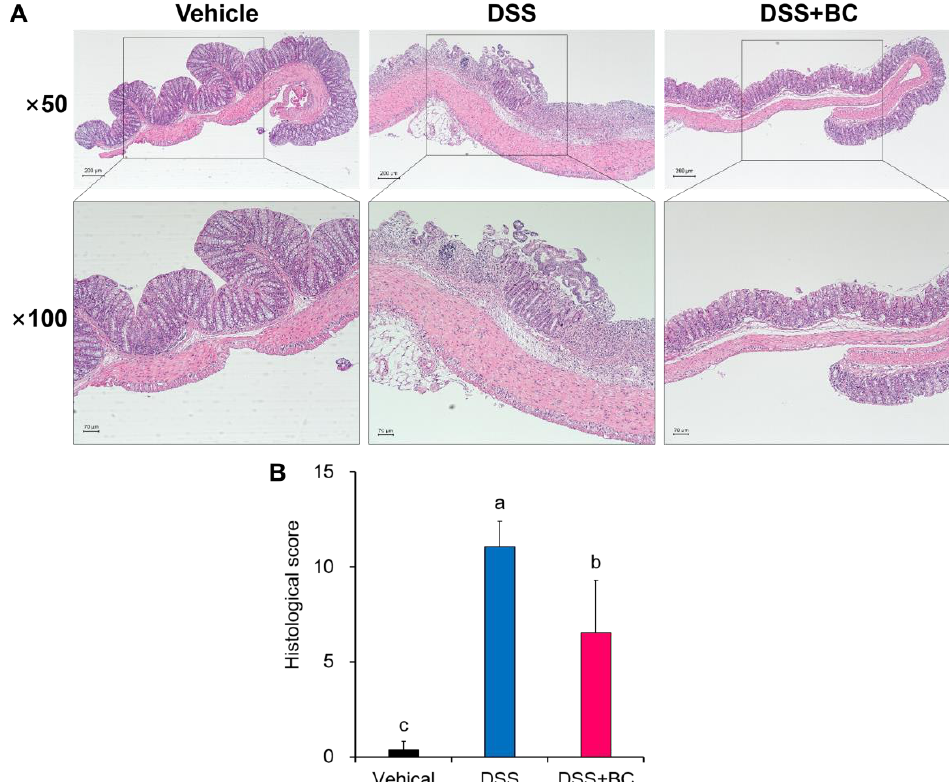
Figure 2. Effects of blackcurrant on the colon damage of DSS-induced colitis. ( A ) Representative images of microscopic colon tissue stained with hematoxylin and eosin (magnification 50× and 100×); ( B ) histology scores of each group. The values are shown as mean ± SD (five sections each within n = 3 per group). Distinct lowercase letters indicate significant differences between groups through one-way ANOVA and Duncan’s post hoc tests ( p < 0.05). Vehicle, normal control group not treated with DSS; DSS, DSS control group; DSS+BC; DSS + blackcurrant group.